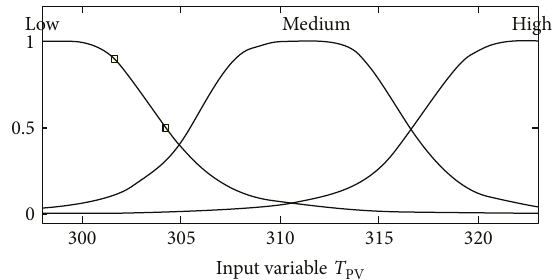
Figure 10: The membership function of the input variable ( T PV ).